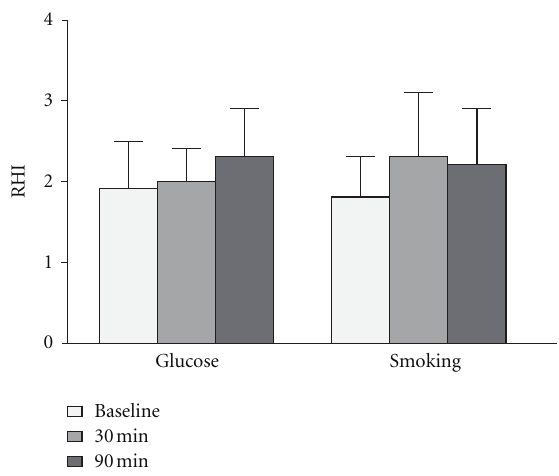
Figure 1: Interventions and endothelial function. Reactive hyper- emia index was assessed before and at 30 and 90 minutes after an oral glucose load (left) or after cigarette smoking (right).